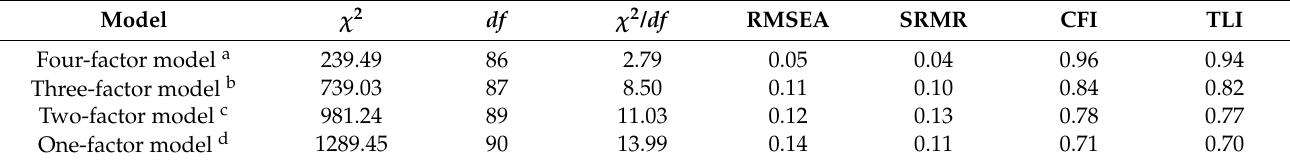
Table 1. Confirmation factory analysis.